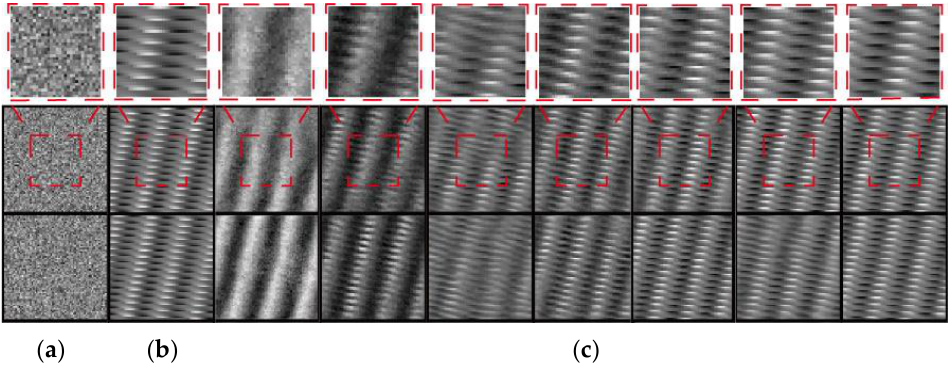
Figure 8. Training Process of TA-UNet for SNR = −4 5 dB simulation signal noise reduction. ( a ) outer fault impulse signal; ( b ) simulation signal with SNR = −4 5 dB; ( c ) training process of TA-UNet, epochs are 10 in turn, 20, 30, 40, 60, 80, 100 (from left to right).